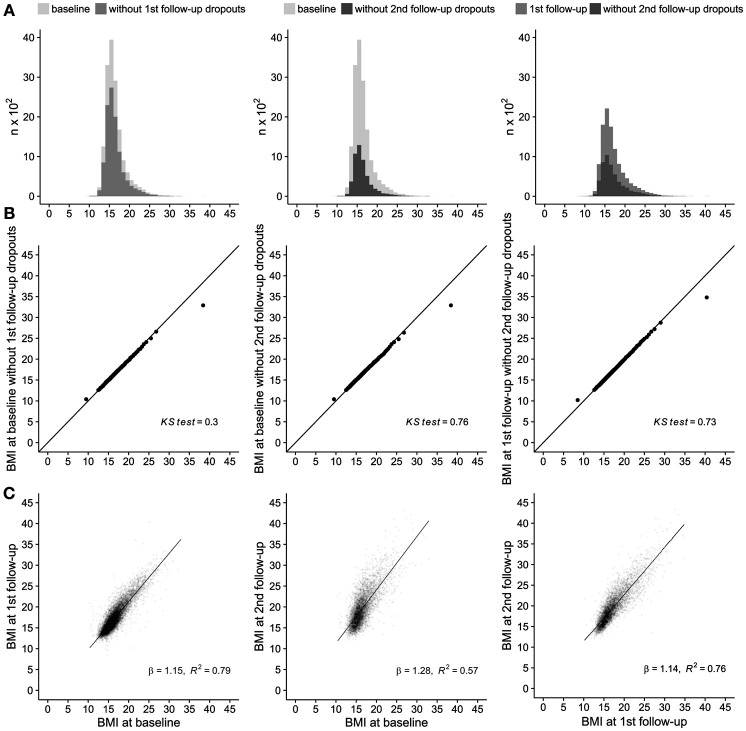
Effect of cohort attrition on the distribution of children's body mass index (BMI). (A) Histograms of children's BMI at baseline for different subgroups show no evidence for differences in distributions. Left: full baseline sample vs. baseline sample without attrition at first follow-up; middle: full baseline sample vs. baseline sample without attrition at second follow-up; right: first follow-up sample vs. first follow-up sample without attrition at second follow-up. (B) Quantile-quantile plot (Q-Q plot) and Kolmogorov-Smirnov test (KS test, 2 sided P value) of children's baseline BMI for different subgroups show no evidence for differences in distributions. Results of KS tests (all p ≥ 0.3) also indicate insufficient evidence to reject the null hypothesis that the respective distributions are the same. Left: full baseline sample vs. baseline sample without attrition at first follow-up; middle: full baseline sample vs. baseline sample without attrition at second follow-up; right: first follow-up sample vs. first follow-up sample without attrition at second follow-up. (C) Scatter plot and results of linear regressions (ß coefficients and R2) between children's BMI at different time points indicate that the correlation was consistent across time. Left: baseline vs. first follow-up, middle: baseline vs. second follow-up; right: first follow-up vs. second follow-up.